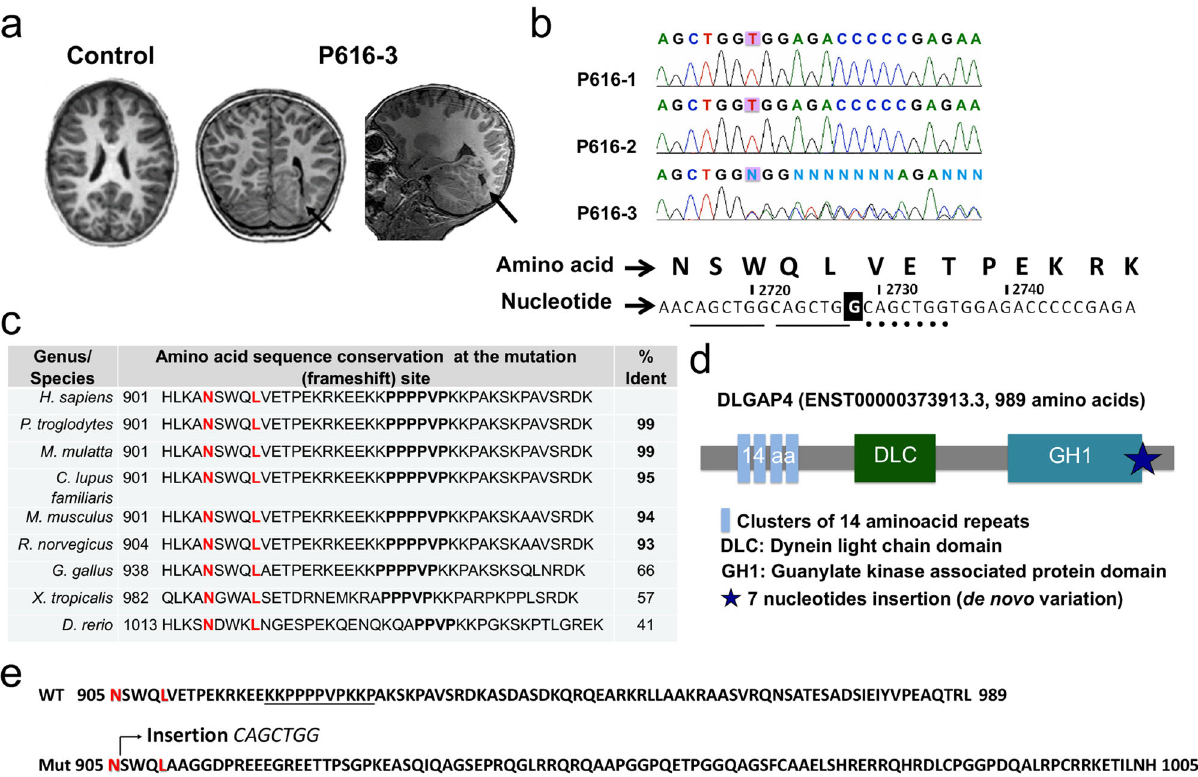
Fig. 1 DLGAP4 mutation is associated with human cortical malformations. a Representative T2-coronal brain MRIs of heterotopia patient (P616-3) were performed at the age of 10 years old, compared to an aged-matched control. The arrow indicates the region of the heterotopia in axial and sagittal sections. b Con fi rmation of a 7-nucleotide insertion (CAGCTGG, three repeats instead of two) using Sanger ’ s sequencing method. The mutation is absent from the parents (P616-1 and 2) and identi fi ed as de novo in P616-3. c Conservation of the mutated region during evolution. The “ % Ident ” refers to the complete primary structure compared to the canonical human sequence. The region of the repeats starts at aminoacid (aa) N905, an extra repeat leads to aa changes from aa L909. d Structure and domains of DLGAP4 protein. A star indicates the region of the mutation. e Comparison of the WT and mutant C-terminal regions showing new aa from